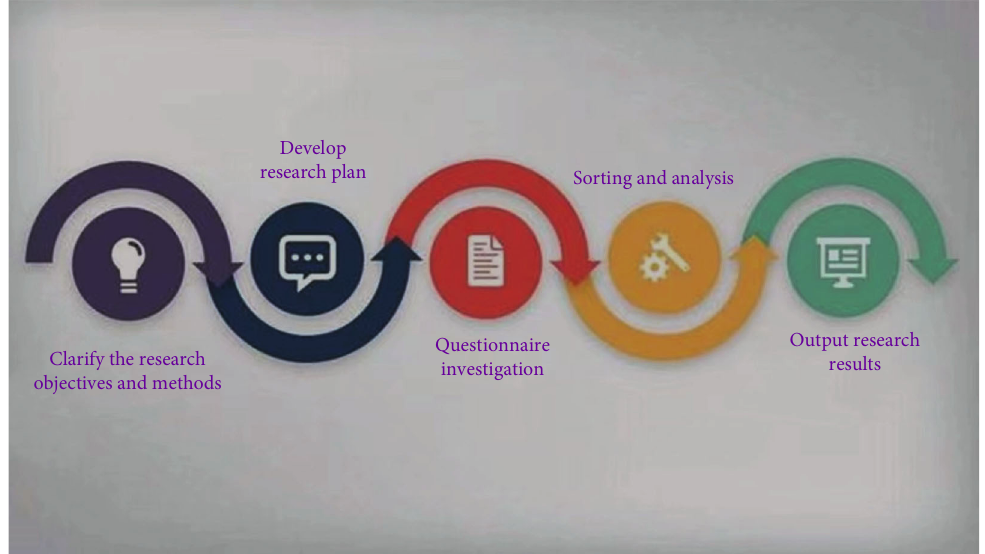
Figure 8: Design and research